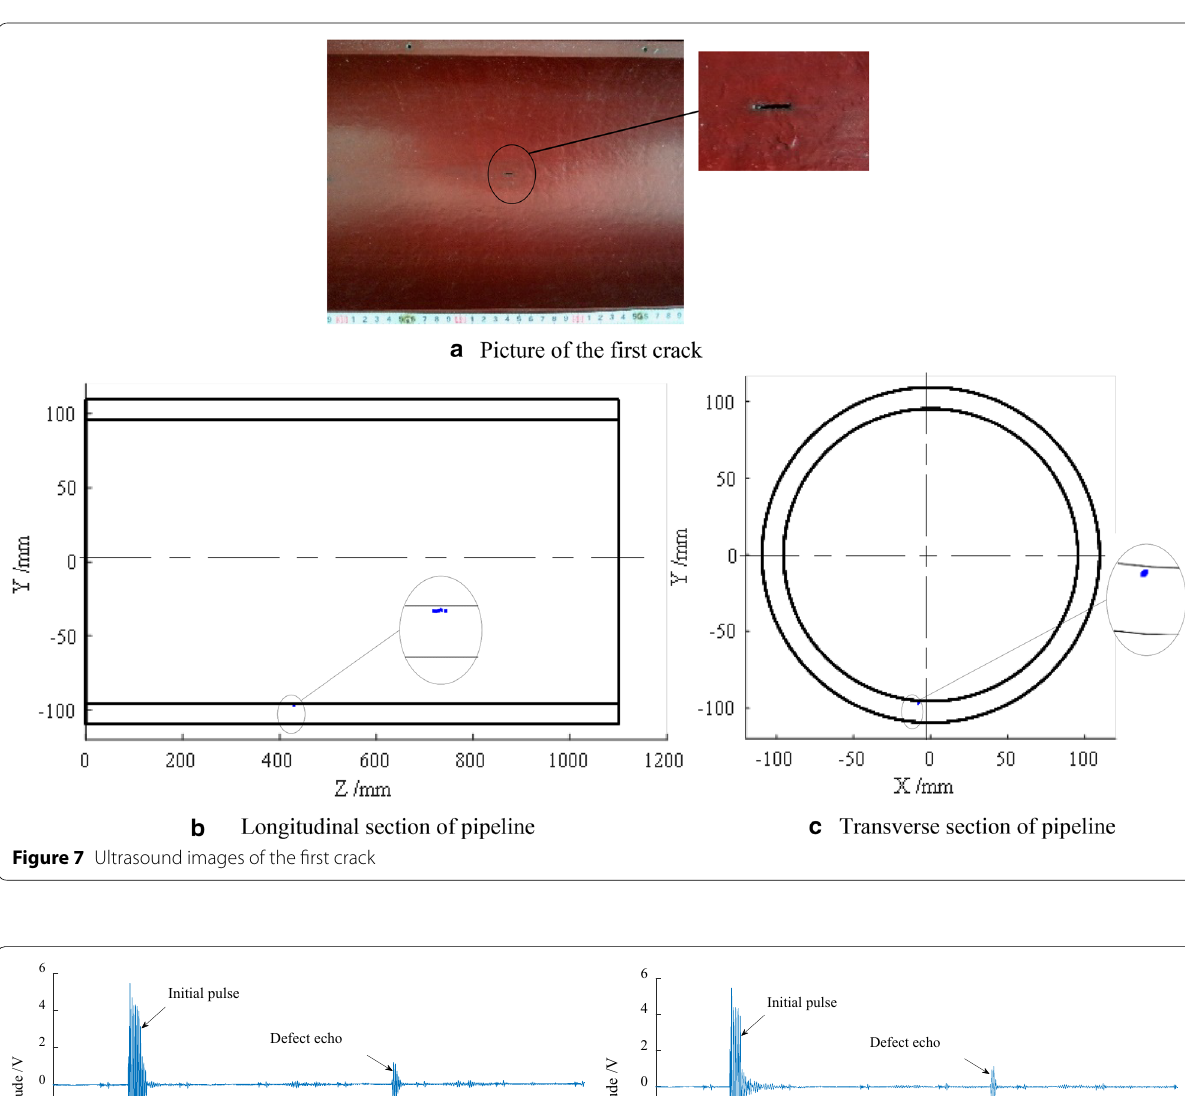
Figure 7 Ultrasound images of the first crack